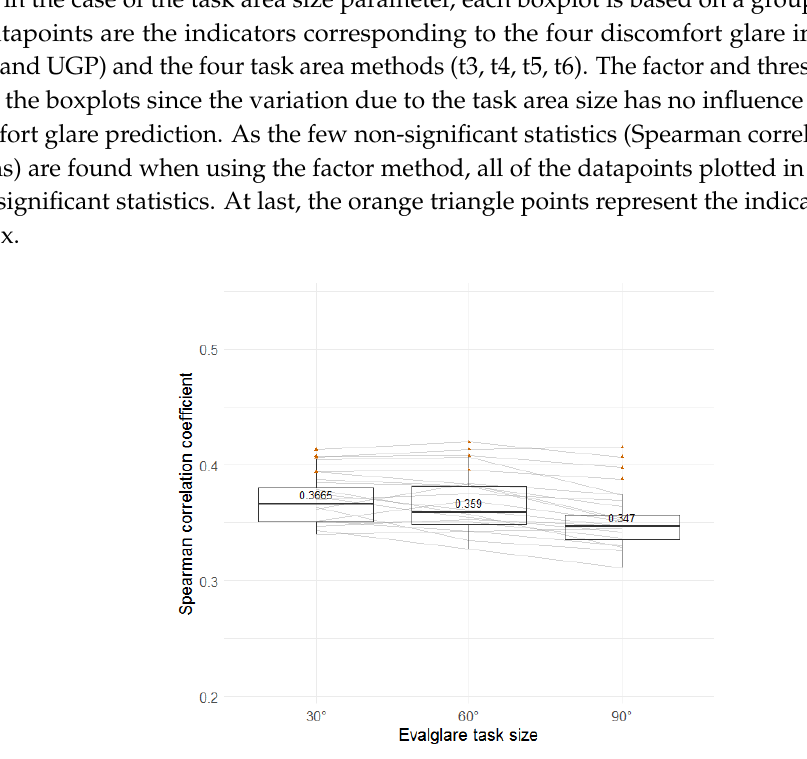
Figure 25. Boxplots of Spearman rho for the three task area sizes (laboratory study).